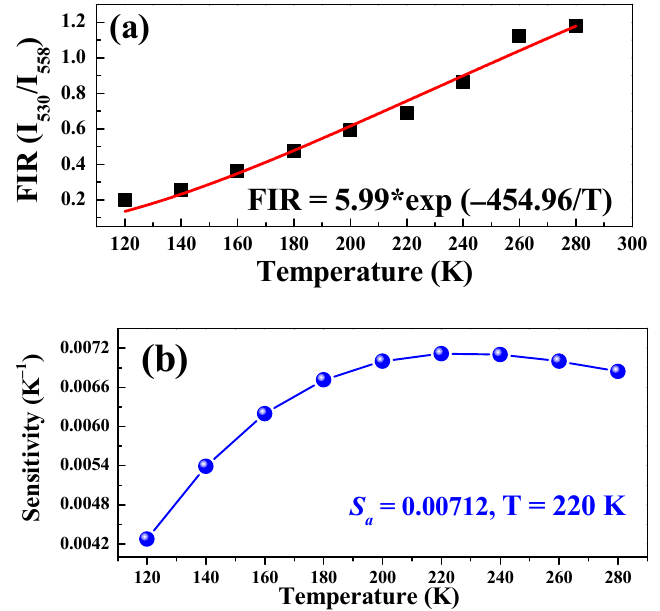
Figure 5. ( a ) Fitted plots of FIR ( I 530 /I 558 ) versus temperature; ( b ) S a as a function of temperature of YNE-1.0.